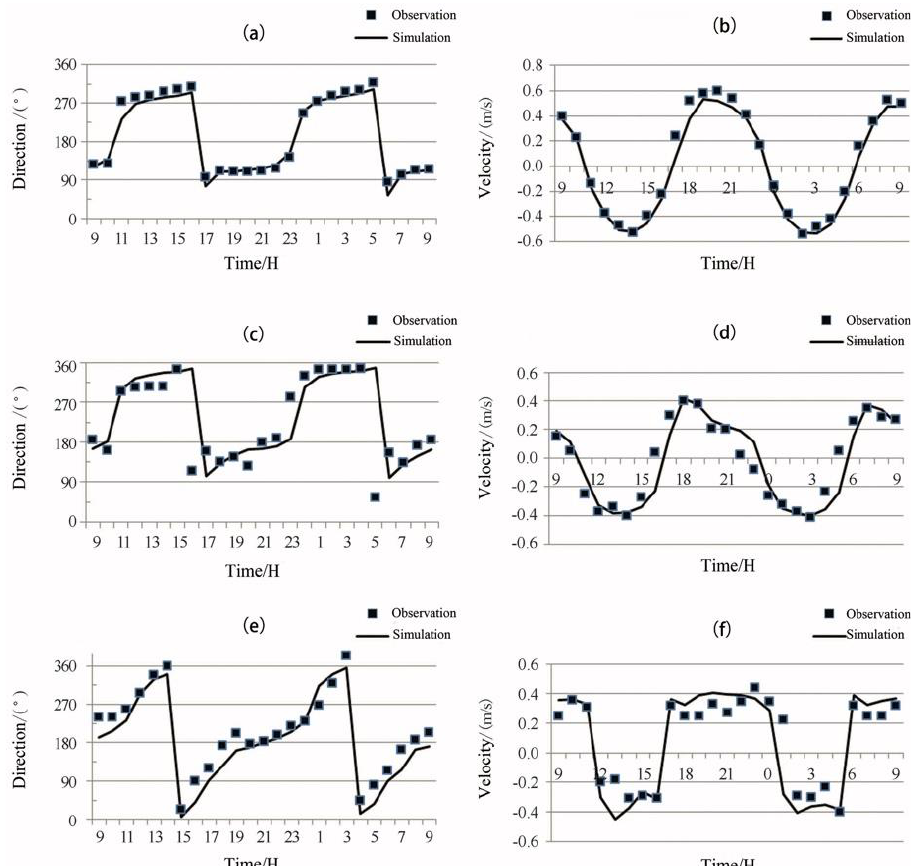
Figure 4. Current velocities and direction during neap tides, ( a , c , e ) stand for direction, ( b , d , f ) stand for velocity.